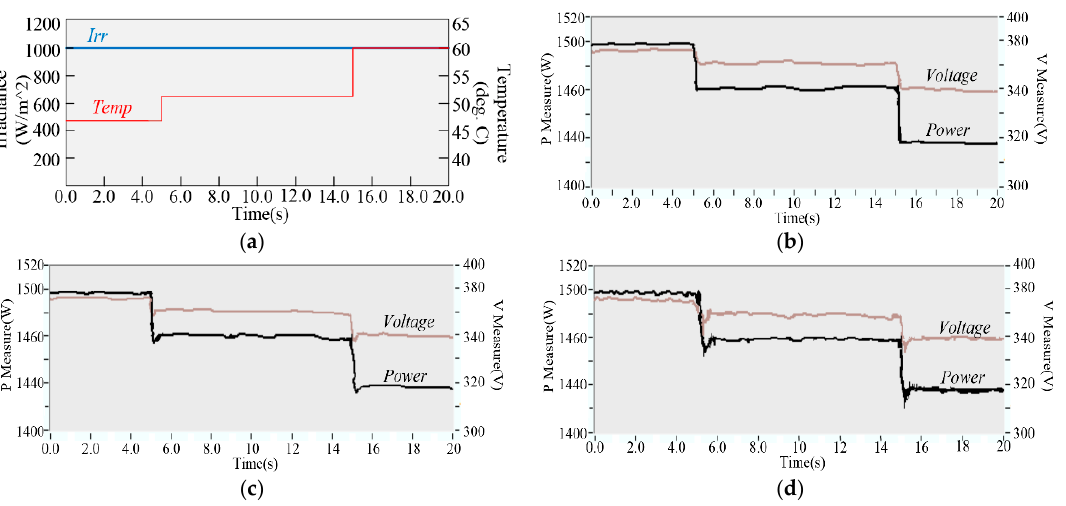
Figure 16. Under temperature step change: ( a ) Experimental results of MPPT control; using ( b ) VUFLC, ( c ) FLC and ( d ) INC.